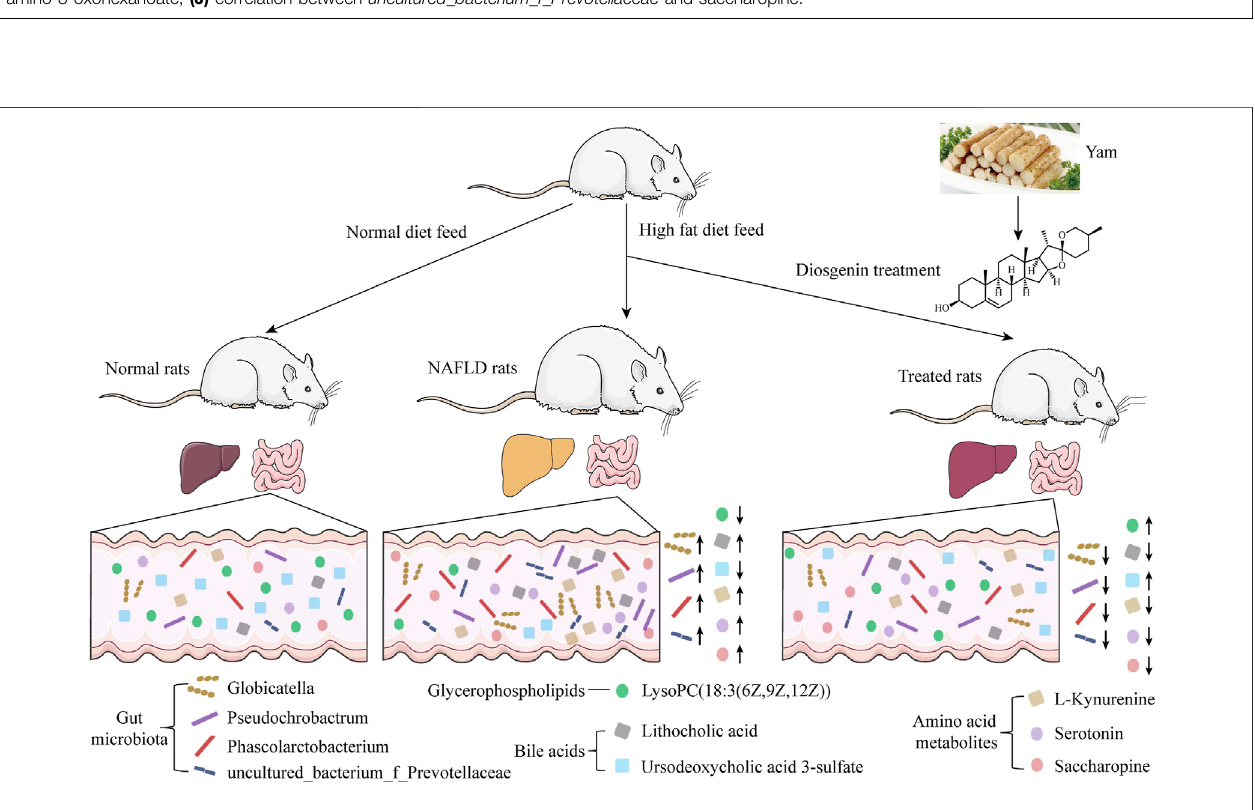
Frontiers in Pharmacology |